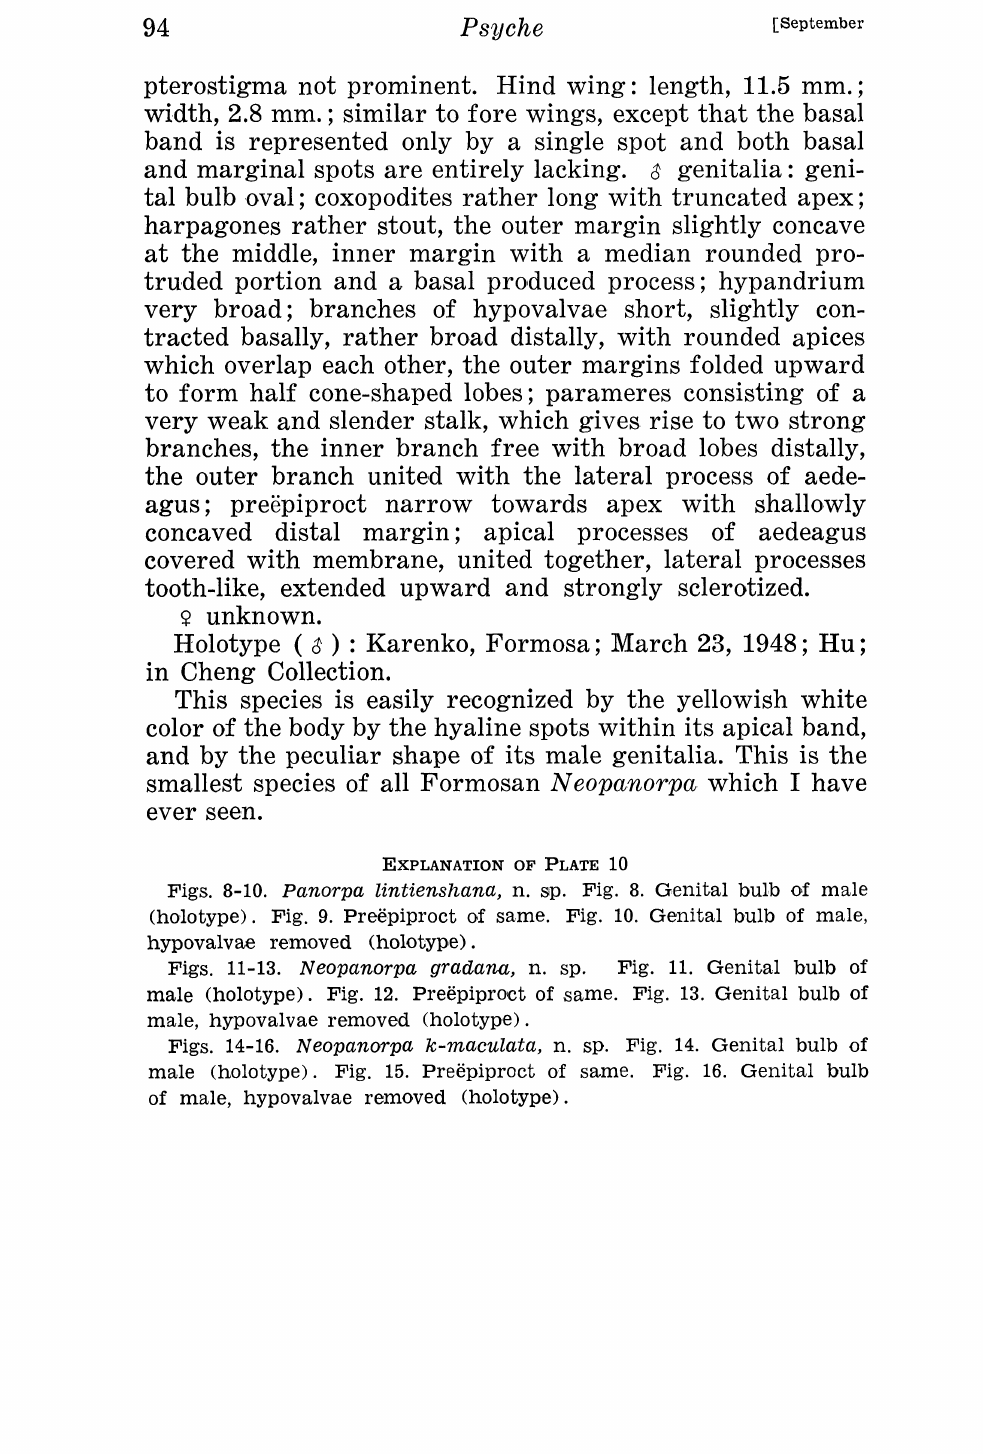
Figs. 8-10. Panorpa lintienshana, n. sp. Fig. 8. Genital bulb of male (holotype). Fig. 9. Prepiproct of same. Fig. 10. Genital bulb of male, hypovalvae removed (holotype). Figs. 11-13. Neopanorpa gradana, n. sp. Fig. 11. Genital bulb of male (holotype). Fig. 12. Prepiproct of same. Fig. 13. Genital bulb of mule, hypovalvae removed (holotype). Figs. 14-16. Neopanorpa k-ma.culata, n. sp. Fig. 14. Genital bulb of male (holotype). Fig. 15. Prepiproct o.f same. Fig. 16. Genital bulb of male, hypovalvae removed